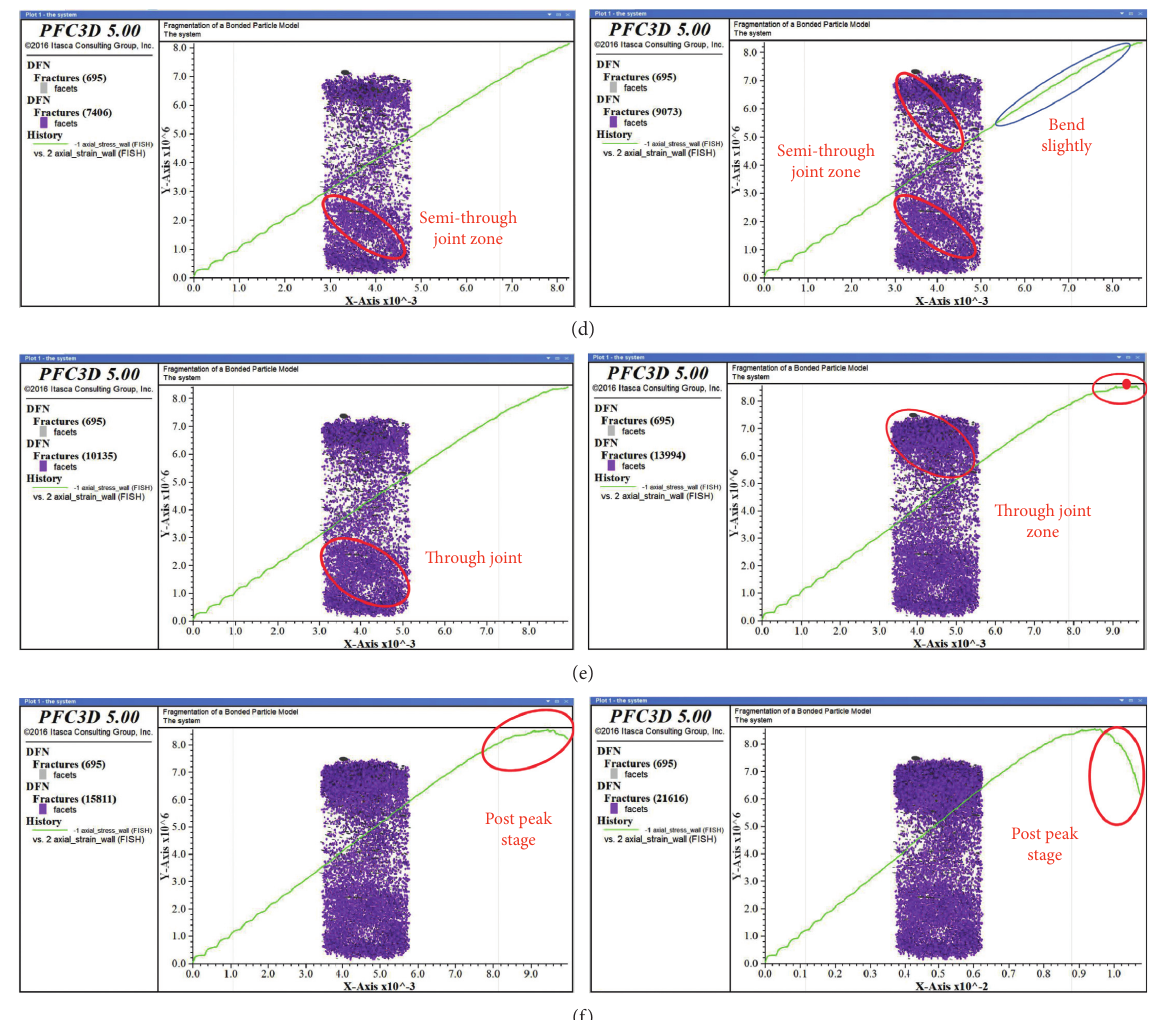
Figure 15: (a) Stress-strain curve for coal sample 4. (b) Joint compacting stage. (c) Elastic deformation stage. (d) Initial expansion phase. (e) Destruction phase. (f) Postpeak